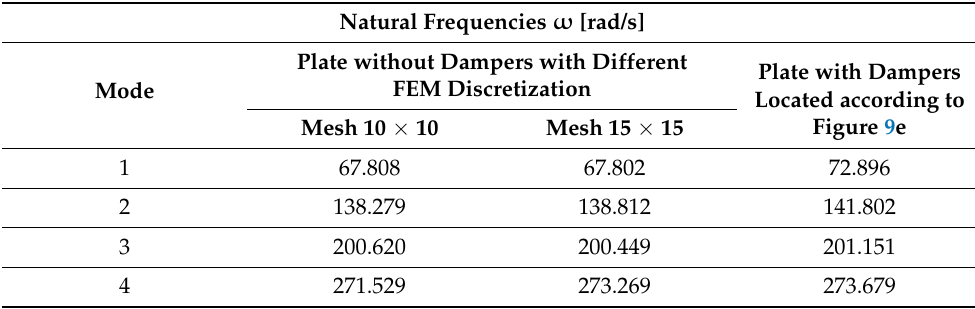
Table 1. The natural frequencies of the plate from Example 2 disregarding the influence of the presence of dampers and taking them into account at the optimal location presence of dampers and taking them into account at the optimal location obtained.